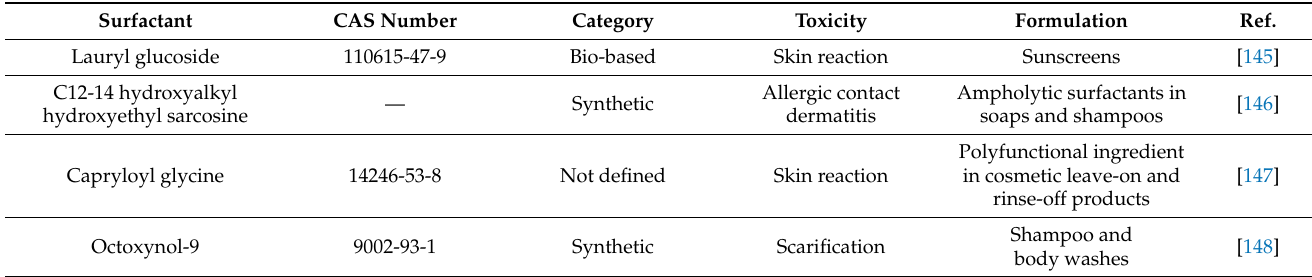
Table 3. Side effects related to synthetic and bio-based surfactants present in cosmetic and personal care formulations.